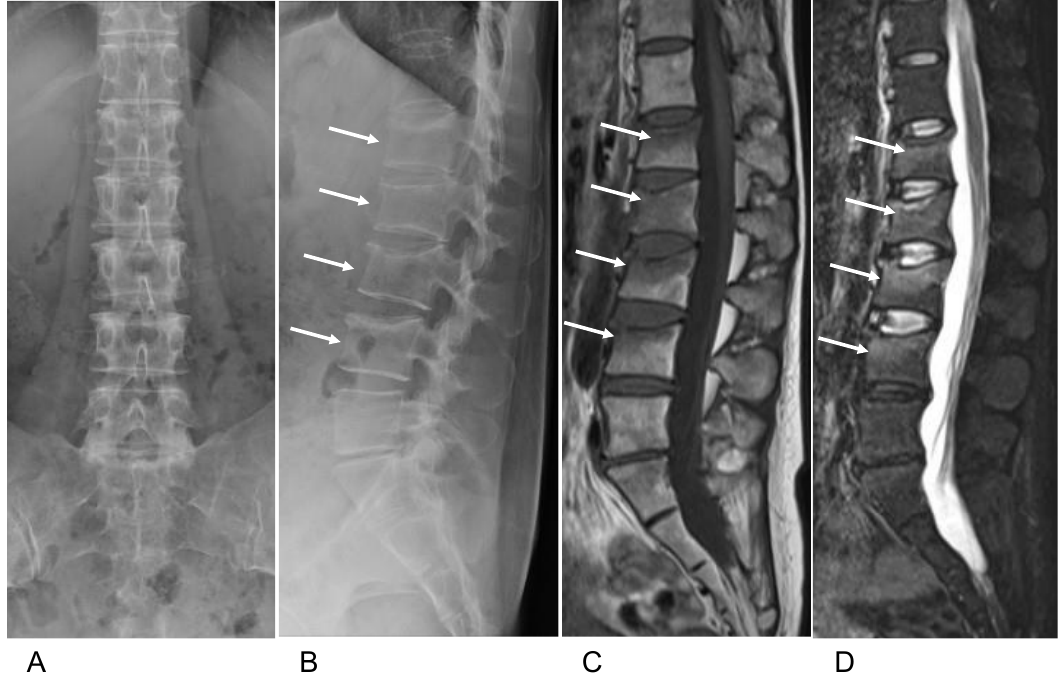
Figure 1. ( A ) Spinal and ( B ) lateral views of the patient ’ s lumbar spine show loss of vertebral height at L1 – L4 (arrow). Sagittal lumbar MRI shows a low-intensity lesion at L1 – L4 on T1-weighed imaging ( C ) and a high-intensity lesion on STIR imaging ( D ) (arrow). Table 2. Bone mineral density values before and after romosozumab treatment.